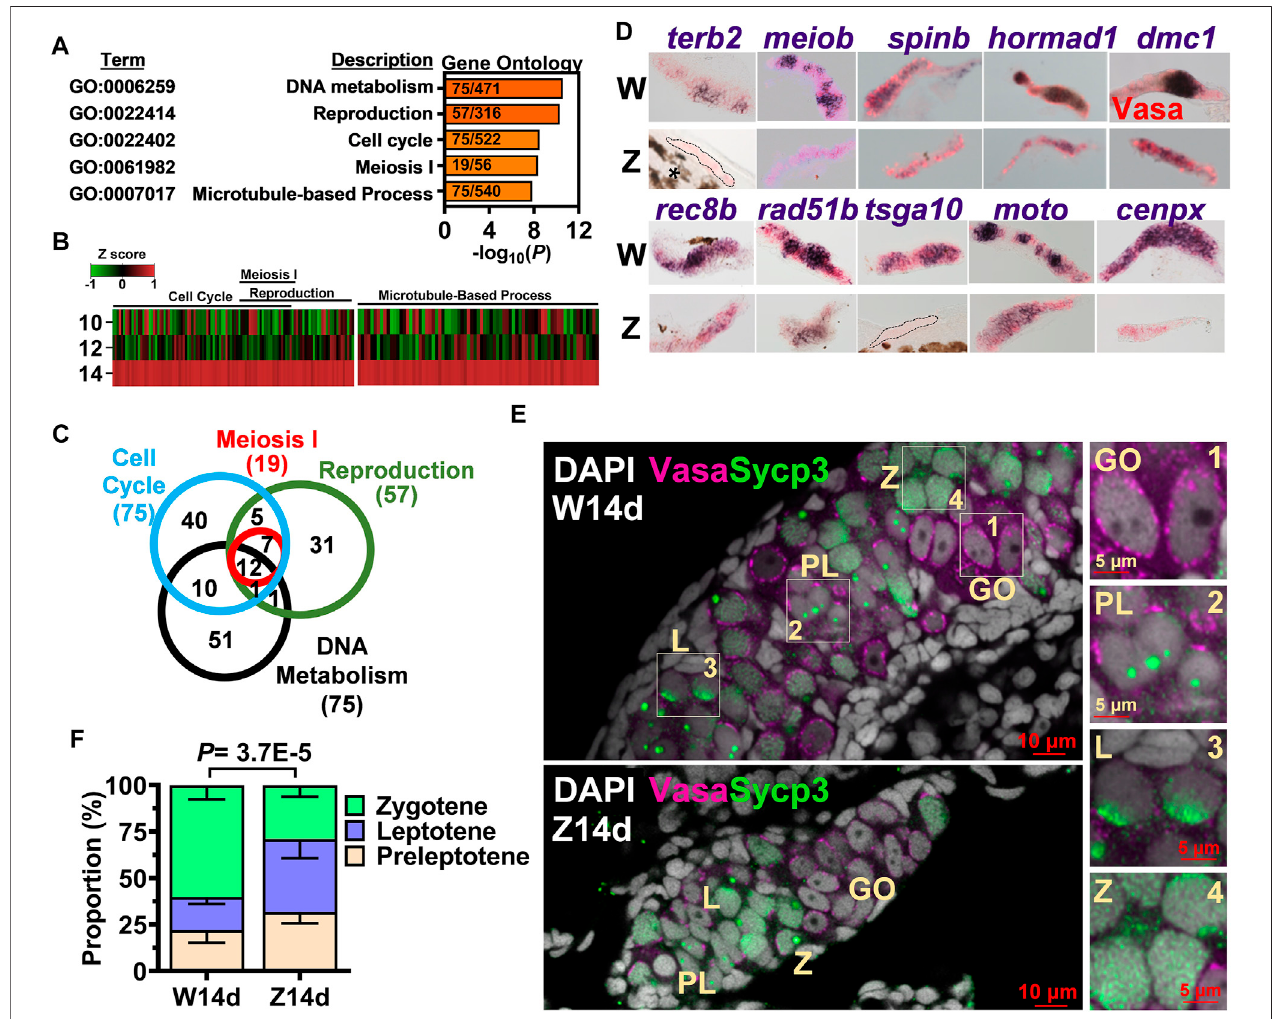
FIGURE 2 | Meiosis as the hallmark of 14-dpf female germ cell transcriptome. (A) . Gene ontology analysis of 1692 genes upregulated in the W-hybrid. (B) . ExpressionofgenesinthemeiosisI,reproduction,cellcycle,and DNAmetabolismat10,12,and 14dpf.Onegeneisrepresented byaline,andthecolorrepresentsthe expression level normalized by Z-score. (C) . A Venn diagram showing the overlaps of genes involved in meiosis I, reproduction, cell cycle, and DNA metabolism. (D) . in situ hybridization of 10 meiotic genes in the 14-dpf W- and Z-hybrids. (E) . The immunostaining of Sycp3 in gonocyte (GO), preleptotene (PL), leptotene (L) , and zygotene (Z) germ cells. Germ cells marker Vasa and meiotic gene marker Sycp3 are magenta and green, respectively. DAPI are shown in white. The boxed regions are enlarged at the right side (1 – 4). (F) . The W-hybrid advances meiosis faster than the Z-hybrid at 14 dpf. The proportion of preleptotene (yellowish), leptotene (blue), and zygotene (light green) are shown. The p value was calculated using the chi-squared analysis.